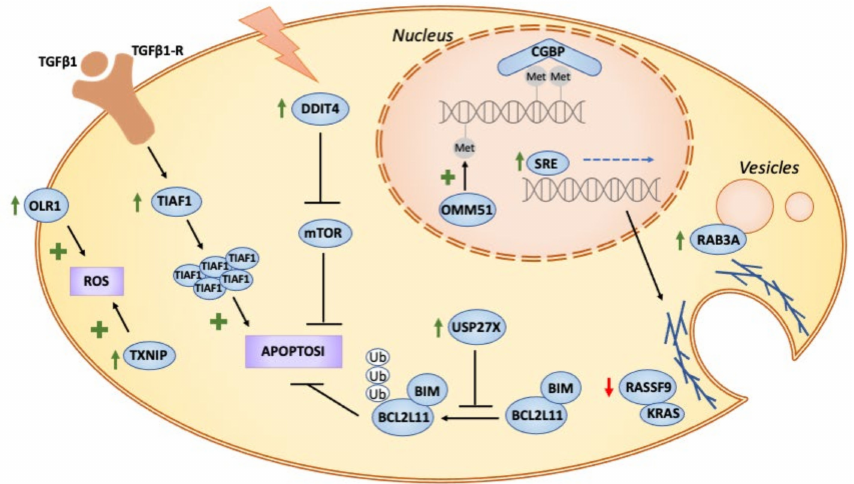
Figure 6. Schematic illustration of the proposed molecular mechanism of A. baumannii infection in mammalian cells. Based on our DEGs analysis we propose an increase in ROS production that may be due, in part, to the upregulation of OLR1 and TXNIP. Apoptosis is also activated by key genes, such as DDIT4, TIAF1 and BCL2L11. Additionally, the infection affects the vesicles traffic, via RAS and Rab3a, that may modulate the entrance and survival of the pathogen inside the host cell vesicles. In addition, cytoskeleton-related proteins that mediate vesicle traffic could be regulated in the nucleus by the transcription factor SRE. Finally, we suggest that epigenetic regulation through CGBP and DMM51 may play a role by regulating methylation in CpG